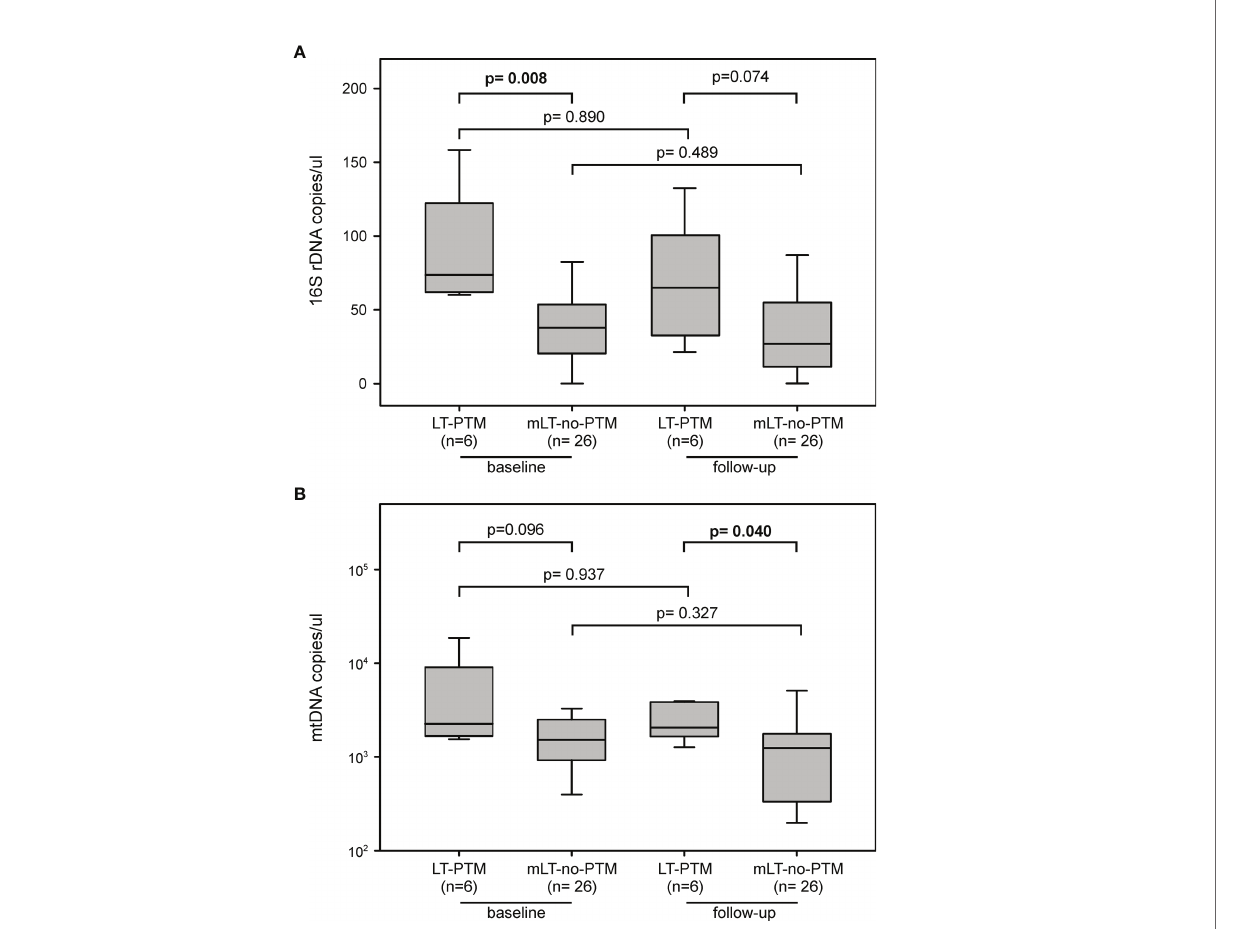
FIGURE 3 | Circulating markers of microbial translocation between LT-PTM and mLT-no-PTM at baseline and follow-up. Circulating levels of (A) PAMPs (16S rDNA) and (B) DAMPs (mtDNA) in LT-PTM versus mLT-no-PTM patients at baseline and